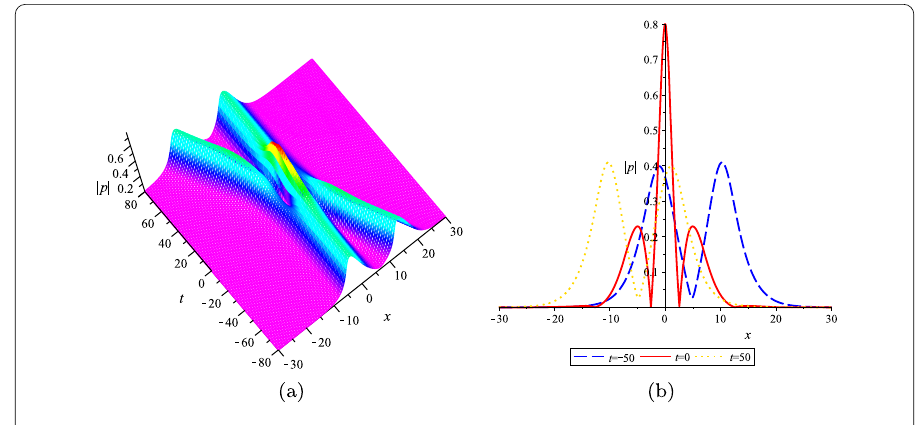
Figure 4 Two-soliton solution (28) with ˜ a 1 = 0.3, ˜ b 1 = ˜ b 2 = 0.2, α 1 = α 2 = β 1 = β 2 = 1, ˜ a 2 = ξ 1 = ξ 2 = 0. ( a ) Perspective view of modulus of p ; ( b ) The soliton along the x -axis with different time in Fig.